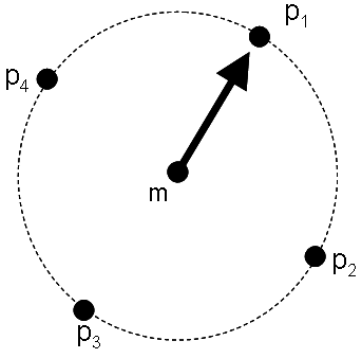
Figure 6. SIFT-based Minutia Descriptor